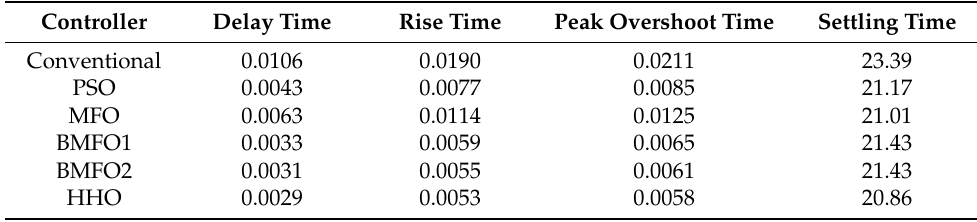
Table 17. Graph analysis of deviation in actual tie-line power flow with various controller under contract violation case.